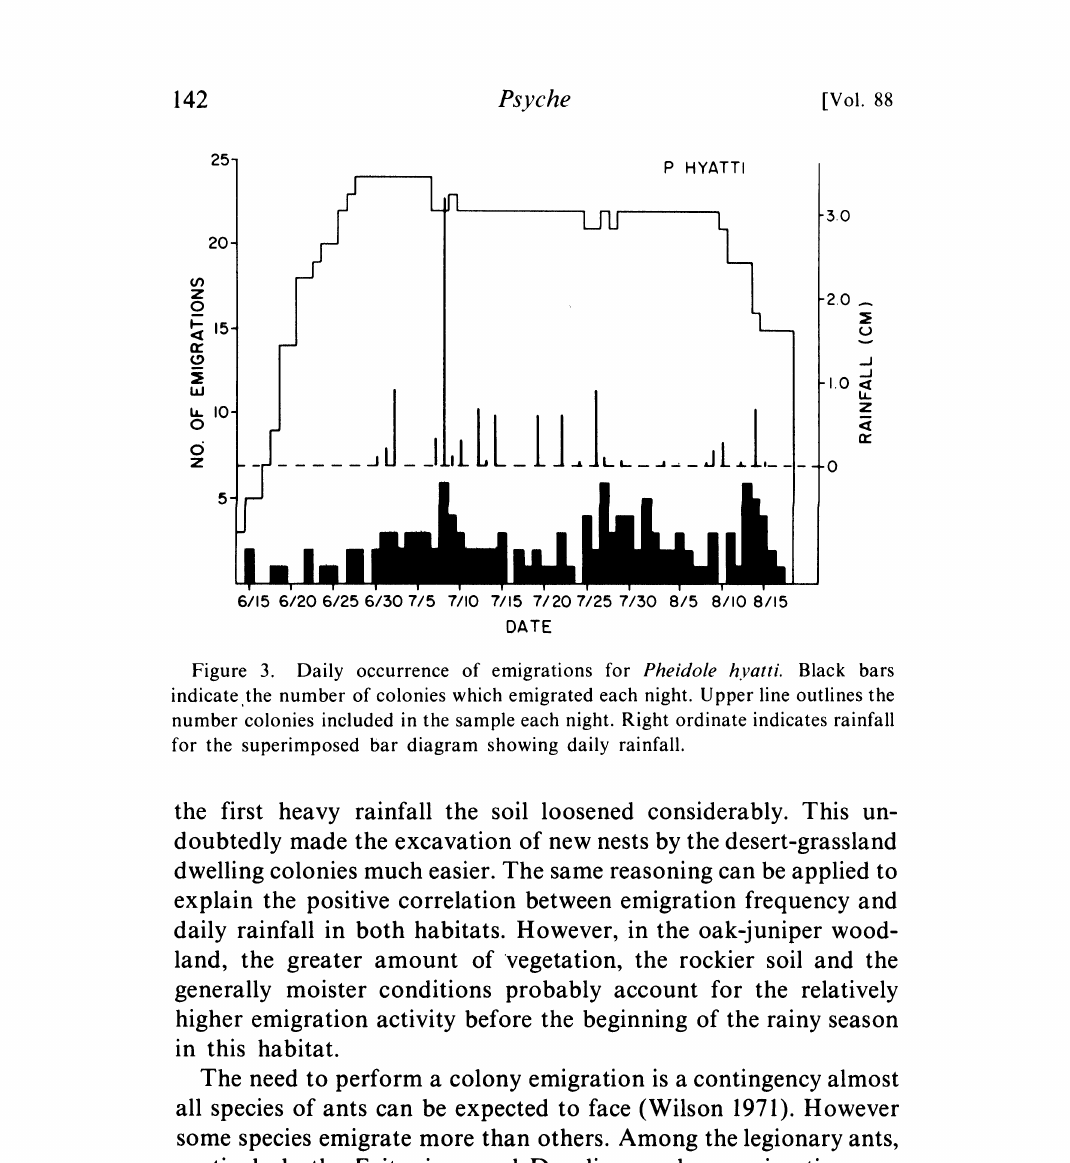
Figure 3. Daily occurrence of emigrations for Pheidole hyatti. Black bars indicate,the number of colonies which emigrated each night. Upper line outlines the number colonies included in the sample each night. Right ordinate indicates rainfall for the superimposed bar diagram showing daily